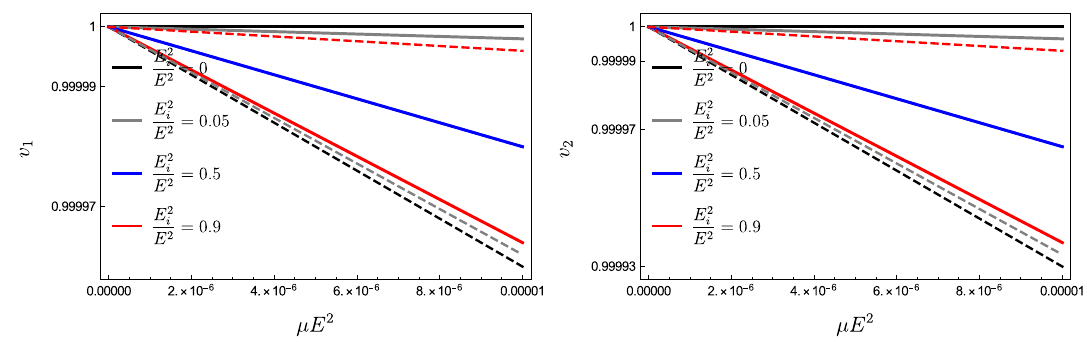
Fig. 4 The phase velocities v i versus μ E 2 are displayed. Veloci- ties approach the ones in vacuum as μ E 2 (cid:14)→ 0. Thick lines corre- spond to different ( E x / E ) 2 and the dashed lines to ( E z / E ) 2 . For the